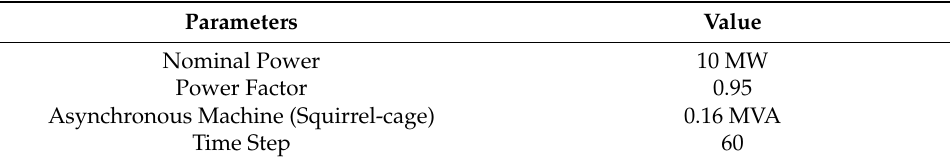
Table 1. Load parameters.